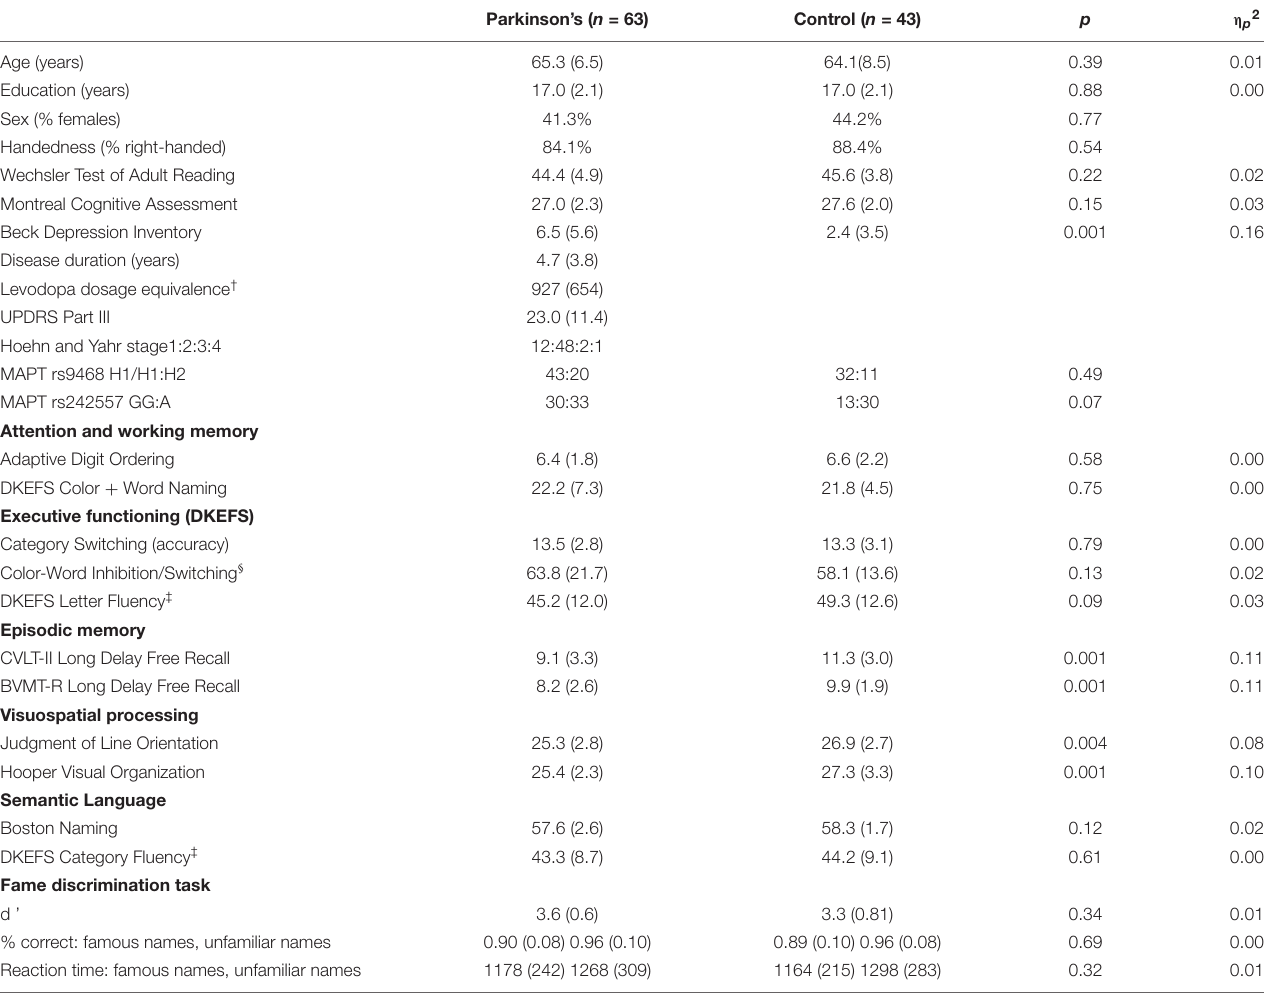
TABLE 1 | Demographic, clinical, genotypic, and cognitive